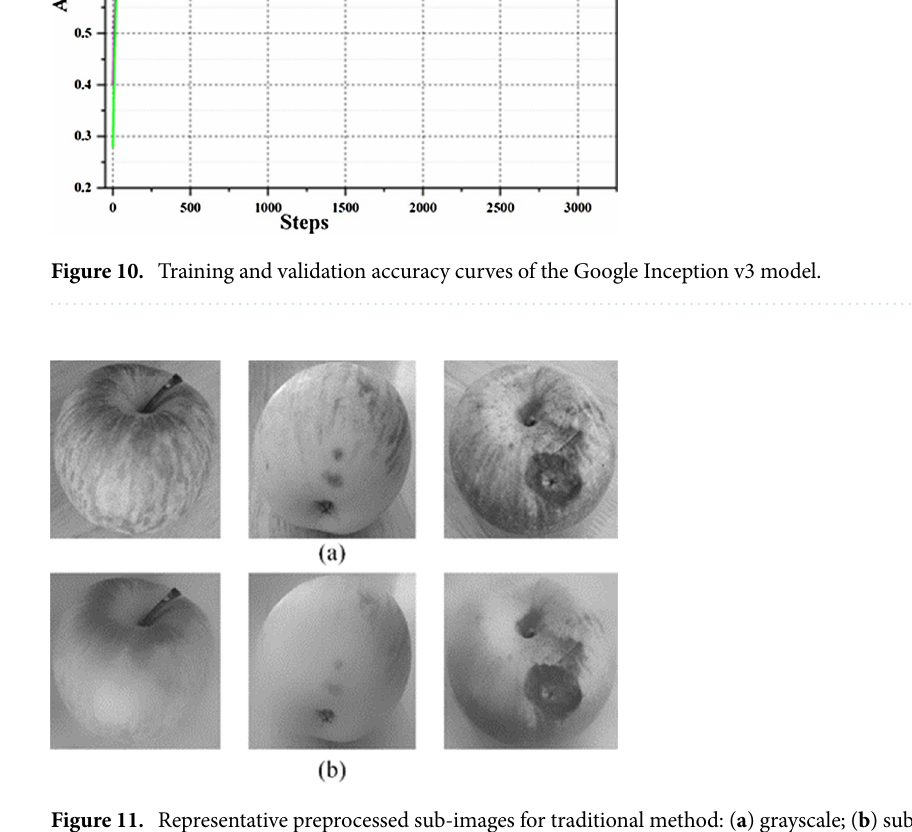
Figure 11. Representative preprocessed sub-images for traditional method: ( a ) grayscale; ( b ) sub-images processed by bilateral